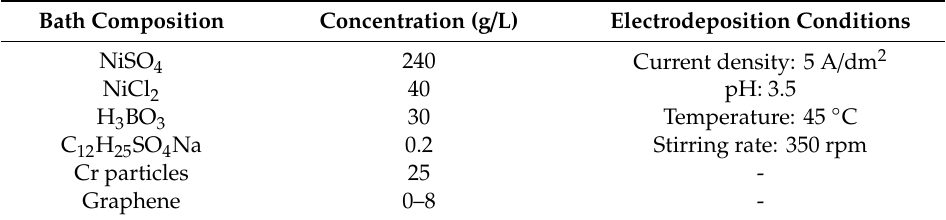
Figure 1. SEM morphologies of the Cr ( a ) and graphene particles ( b ). Table 1. Bath composition and electrodeposition conditions.